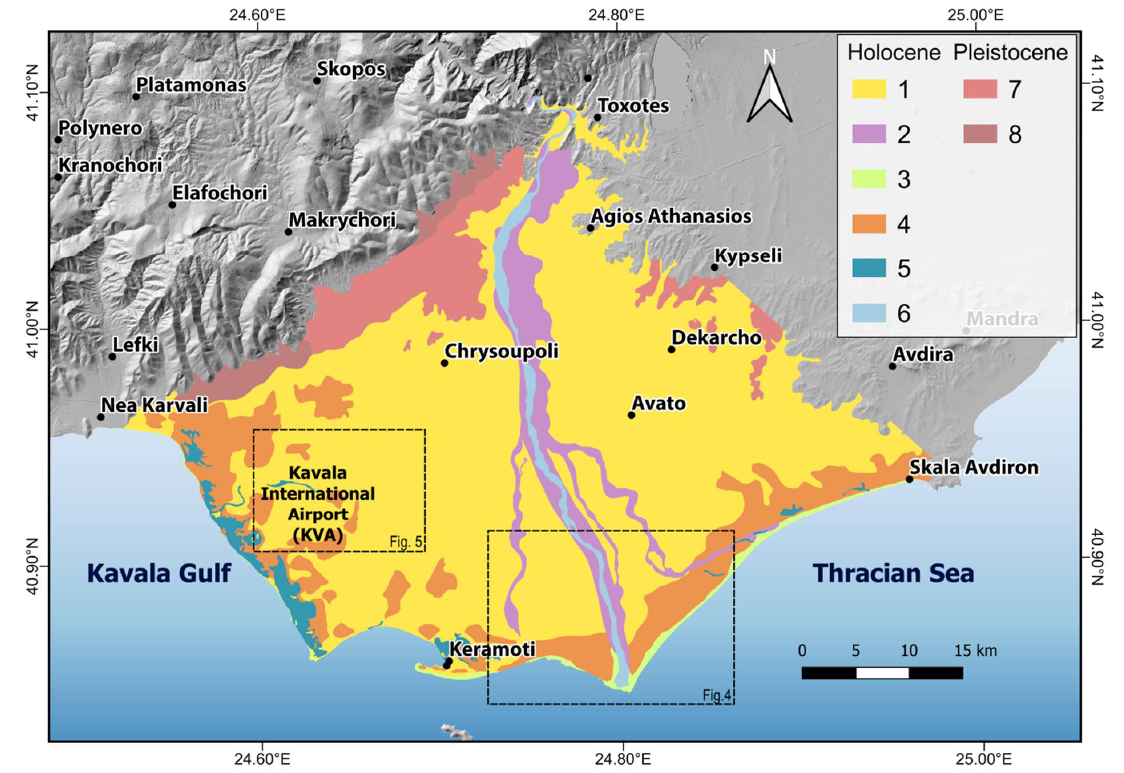
Figure 2. Geological map of the Nestos River delta provided by HSGME with (1) floodplain depos- its, (2) channel deposits, (3) coastal deposits, (4) swamp deposits, (5) lagoons, (6) Nestos River, (7) Pleistocene deposits, (8) screes.